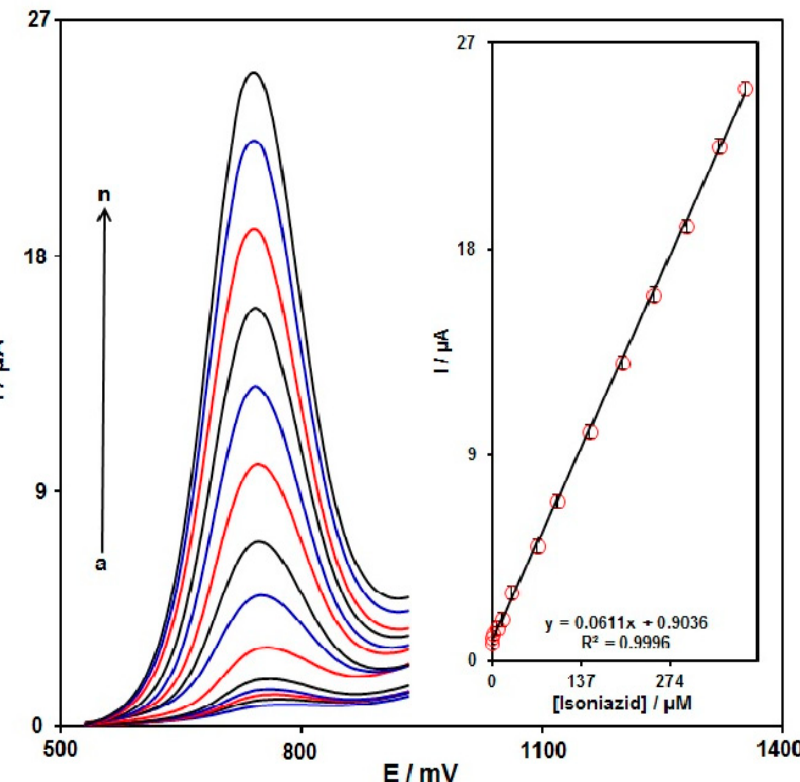
Figure 8. The DPV responses of INZ on MoS 2 NSs-SPE at various INZ contents (a–n: 0.035 µM, 0.2 µM, 2.5 µM, 7.5 µM, 15.0 µM, 30.0 µM, 70.0 µM, 100.0 µM, 150.0 µM, 200.0 µM, 250.0 µM, 300.0 µM, 350 µM, and 390 µM) in PBS (0.1 M, pH = 7.0). Inset: the relationship of INZ oxidation peak currents and various INZ contents.